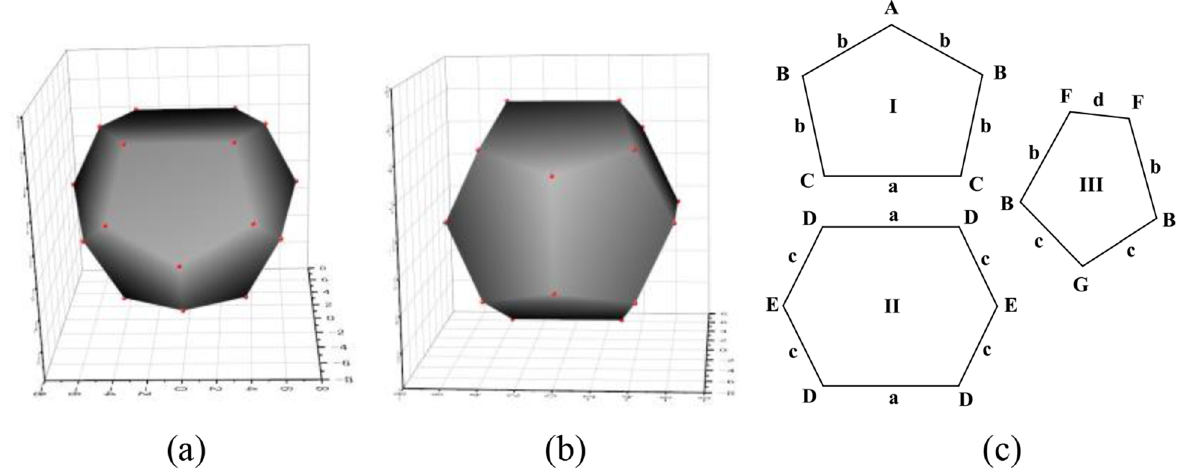
Figure 3. ( a ) Tetrakaidecahedron, ( b ) dodecahedron polyhedrons, and ( c ) pentagon and hexagon structures in the theoretical Weaire-Phelan